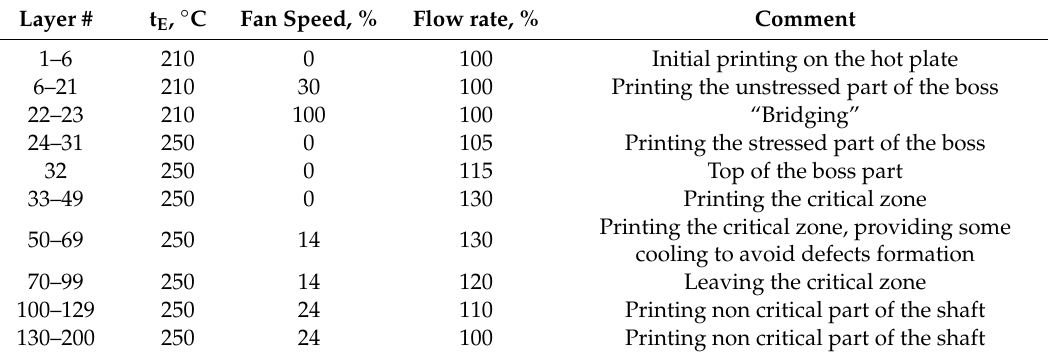
Table 4. Fine tuning of the Fused Filament Fabrication (FFF) process (mode